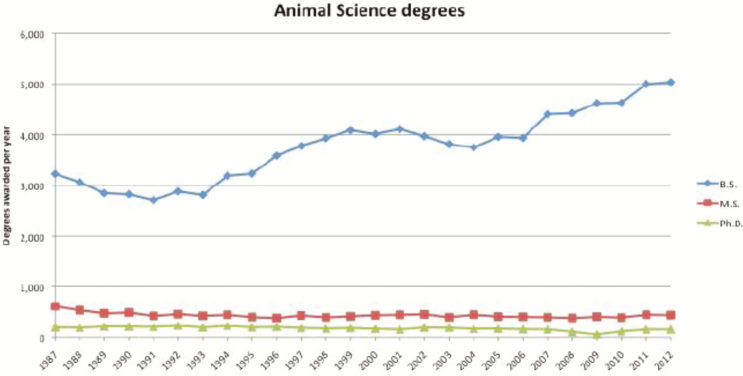
Number of BS, MS, and PhD degrees awarded over a 25-yr period (Knapp, 2014).